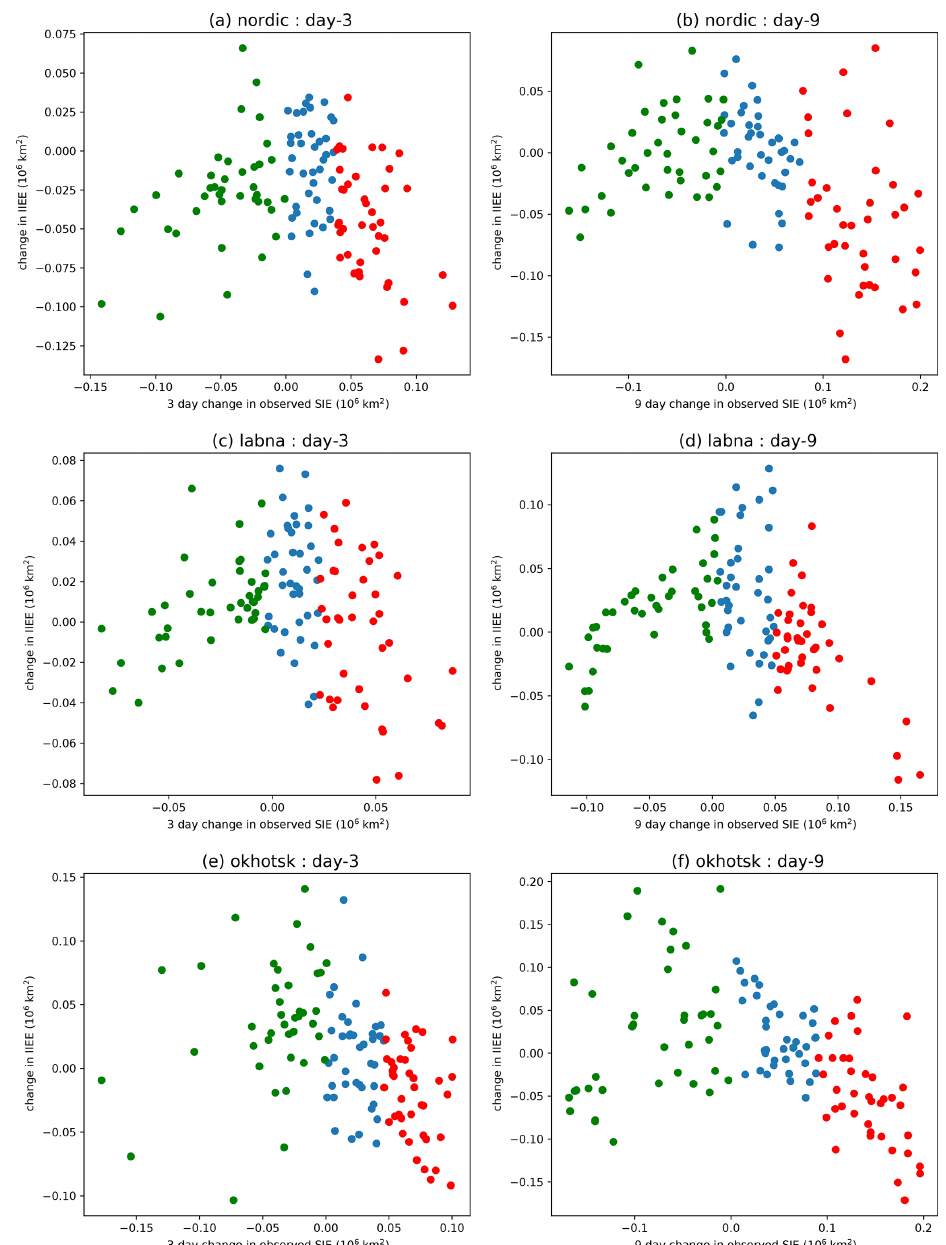
Figure 6. Scatter plot of difference in IIEE between coup-SSTSIC and pers-SSTSIC forecasts at day 3 (a, c, e) and day 9 (b, d, f) and the change in observed ice extent between the initial time and the verification time for the Nordic Seas (a, b) and the Labrador–North-East Atlantic (c, d) and the Sea of Okhotsk (e, f) regions. These regions are shown in Fig. 1c and f. Colours correspond to the lowest (green), middle (blue) and highest (red) terciles of ice extent